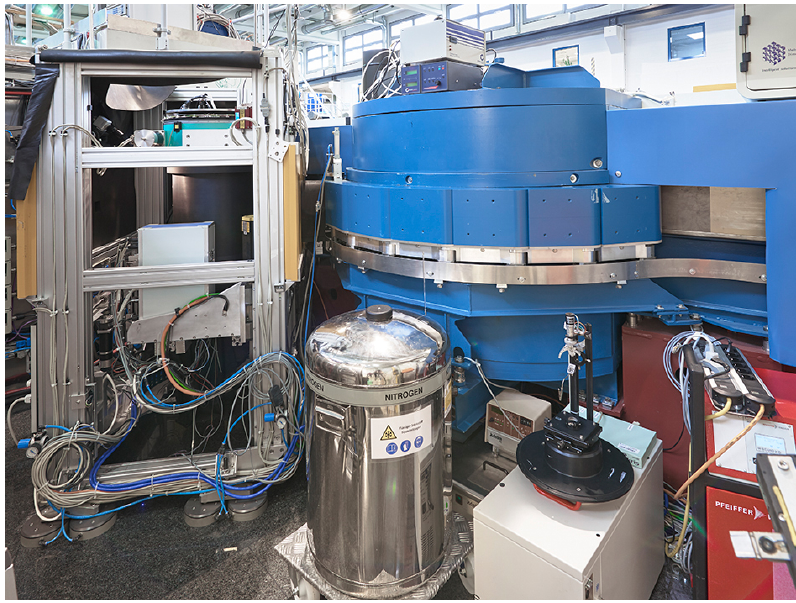
Figure 1: Instrument BIODIFF with the detector unit on the left side, monochromator shielding (blue) on the right side (Copyright by W. Schürmann,